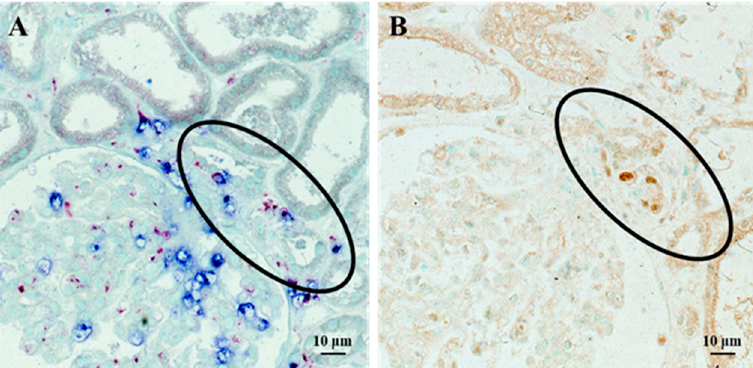
Figure 6. Staining of infiltrating cells and PCNA in serial sections of renal biopsy tissue from a patient with PSAGN. Double staining for neutrophils (chloroesterase staining: blue) and macrophages (immuno-alkaline phosphatase staining for CD11c: red) demonstrated extensive glomerular infiltration of both cell types, which spread out from the vascular pole (circled region) ( A ). Tubular epithelial cells of the same region (circled) showed positive PCNA staining (immunoperoxidase staining: brown) on a serial section ( B ). Details of all the staining methods have been described previously [22]. Tubulointerstitial changes that develop in this manner persist in the absence of glo- merular inflammation, and may contribute to the progression of PSAGN. The above findings are somewhat consistent with the recent reports on the im- portance of proximal tubular injury and its limited regenerative properties on the transi- tion of AKI into CKD [49–51]. It may be possible to assess the involvement of this factor, tubulointerstitial changes, by the level of interstitial α -SMA expression; however, at present, there are no established therapeutic strategies that potentially modify this factor. The development of medication that modifies interstitial fibrosis, the final common pathway, are expected in the future.